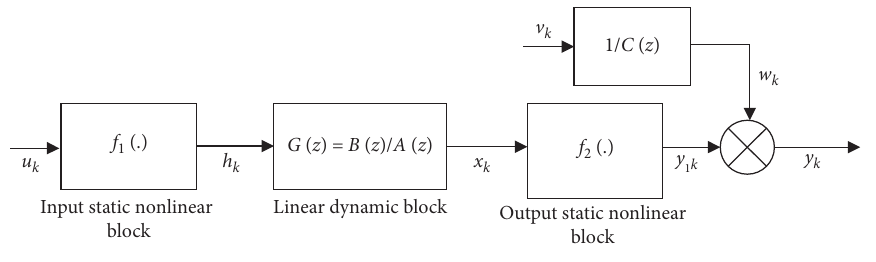
Figure 1: SOEAHW